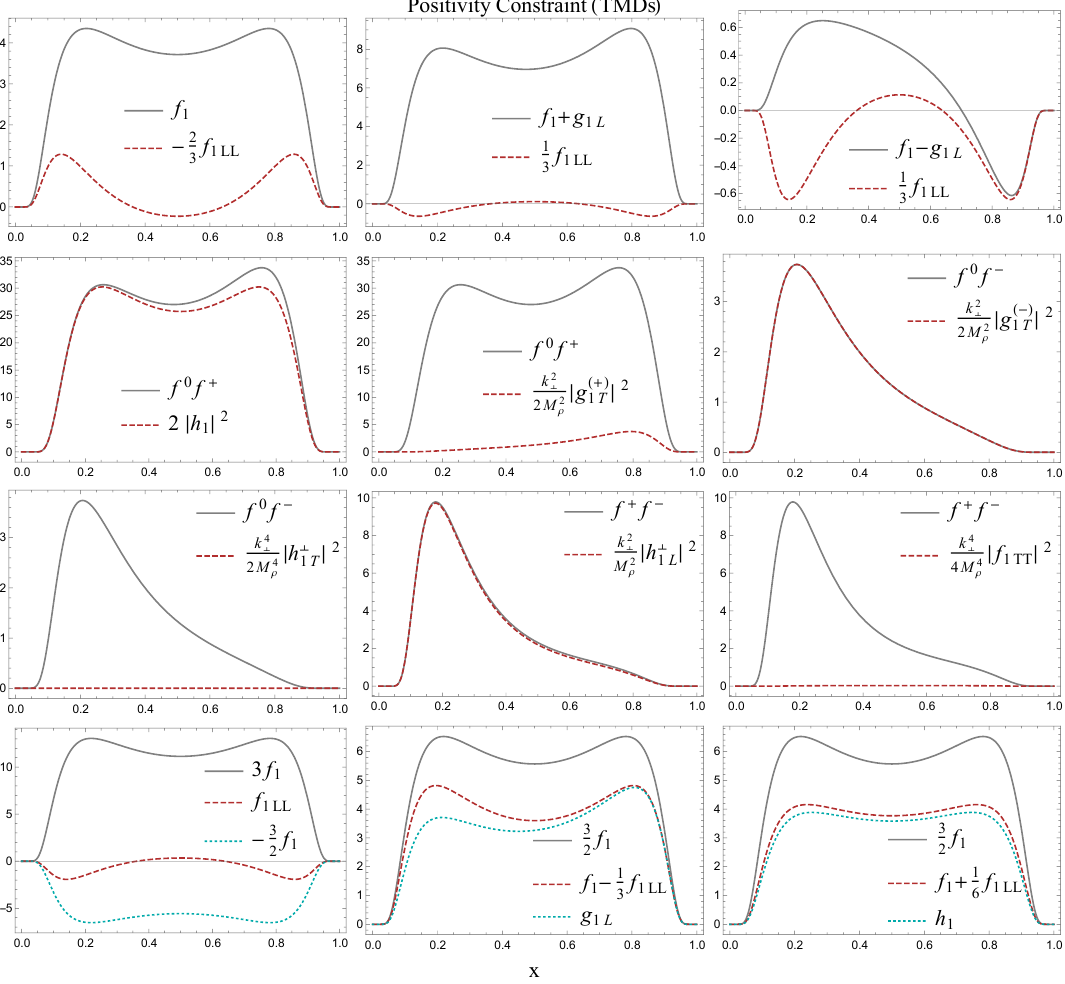
Figure 6 . The positivity constraints on the holographic TMDs, plotted with respect to x at fixed k ⊥ = 0 . 15